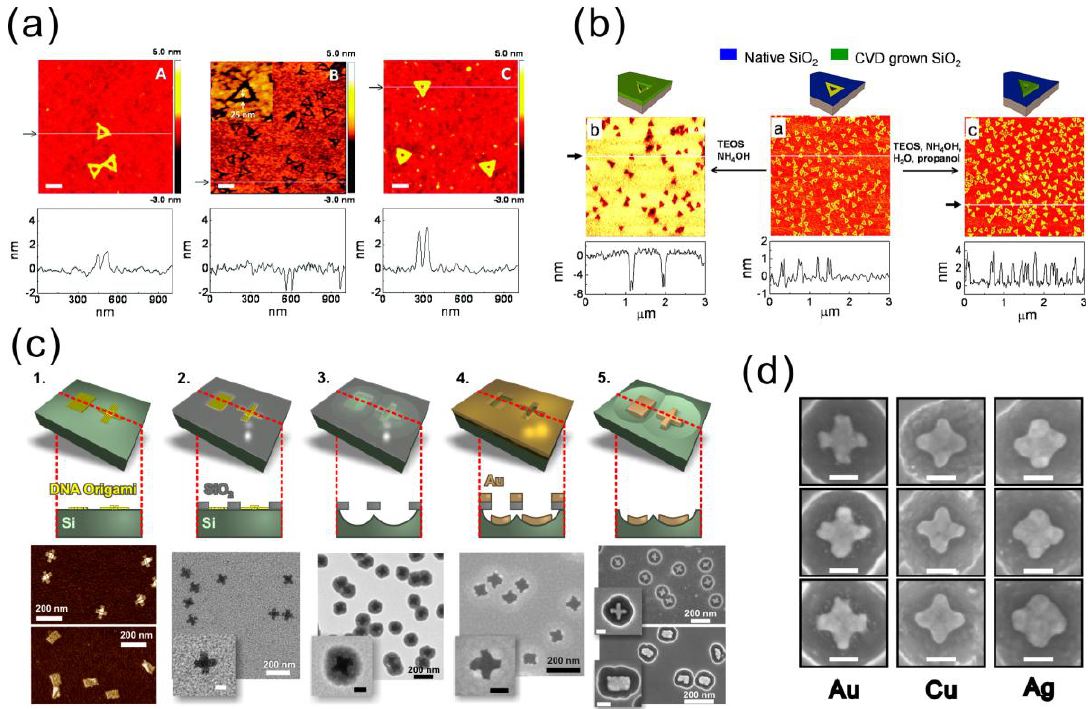
Figure 7. ( a ) DNA origami-modulated etching of SiO 2 by HF vapor [102]; ( b ) room-temperature CVD process for SiO 2 growth using DNA origami as a mask [104]; ( c ) fabrication steps to produce high-resolution metallic shapes on the Si surface using DNA origami stencils [105]; ( d ) similar cross-shaped structures fabricated from different metals via the same origami mask [105]. (a) is reproduced with permission from [102]. Copyright American Chemical Society, 2011; (b) is reproduced with permission from [104]. Copyright American Chemical Society, 2013; (c,d) are reproduced with permission from [105]. Copyright Royal Society of Chemistry, 2015.